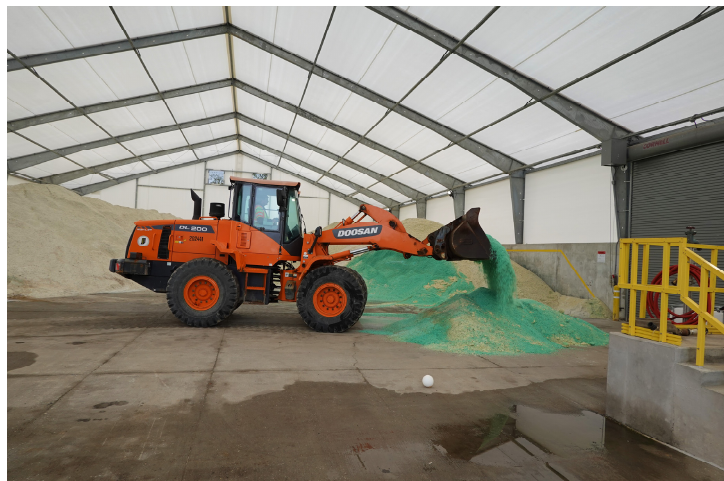
Figure 29. Salt repositioning experiment at the Lebanon